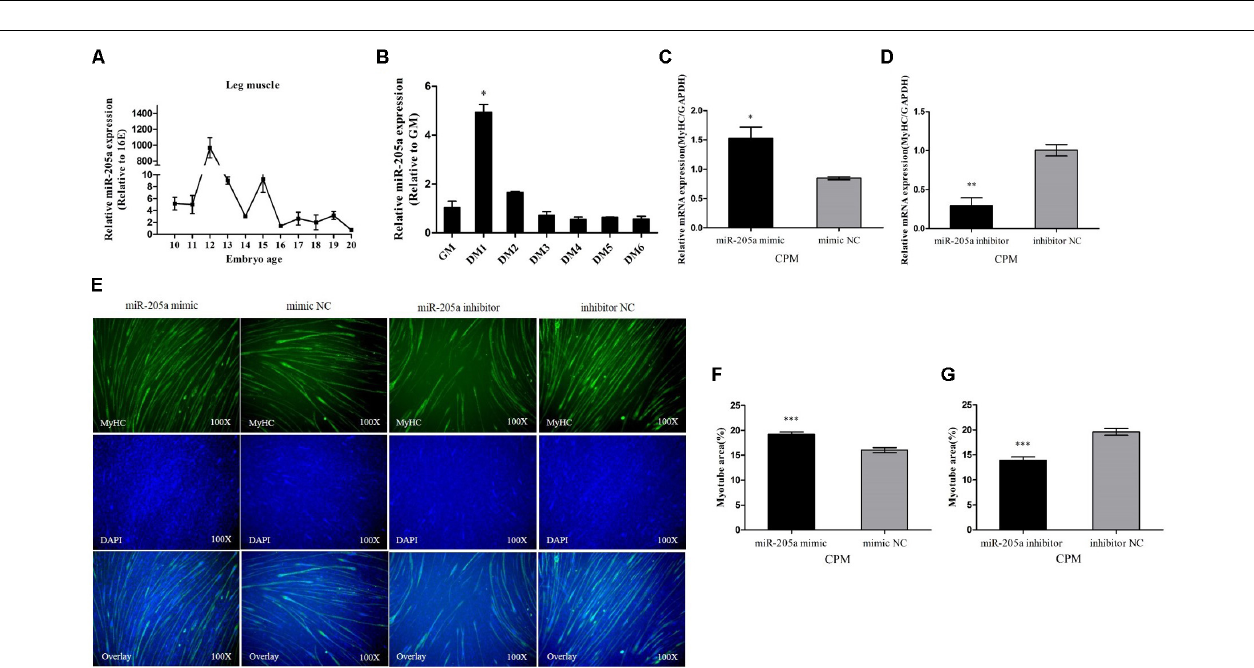
FIGURE 5 | MiR-205a promotes the differentiation of myoblast. (A) The relative expression of miR-205a in chicken embryonic leg muscle. (B) The relative expression of miR-205a during CPM differentiation. GM representing myoblasts in proliferative phase, while DM1......DM6 means myoblasts successfully induced to differentiate from day 1 to day 6. (C,D) The mRNA level of MyHC from miR-205a mimic and inhibitor transfected CPM cells. (E) MyHC staining of CPM cells at 72 h after transfection of miR-205a mimic and inhibitor. (F,G) Myotube area (%) of CPM cells 72 h after overexpression and inhibition of miR-205a. Results are shown as mean ± SEM and the data are representative of at least three independent assays. Independent sample t -test was used to analyze the statistical differences between groups. ∗ P < 0.05; ∗∗ P < 0.01; ∗∗∗ P < 0.001.